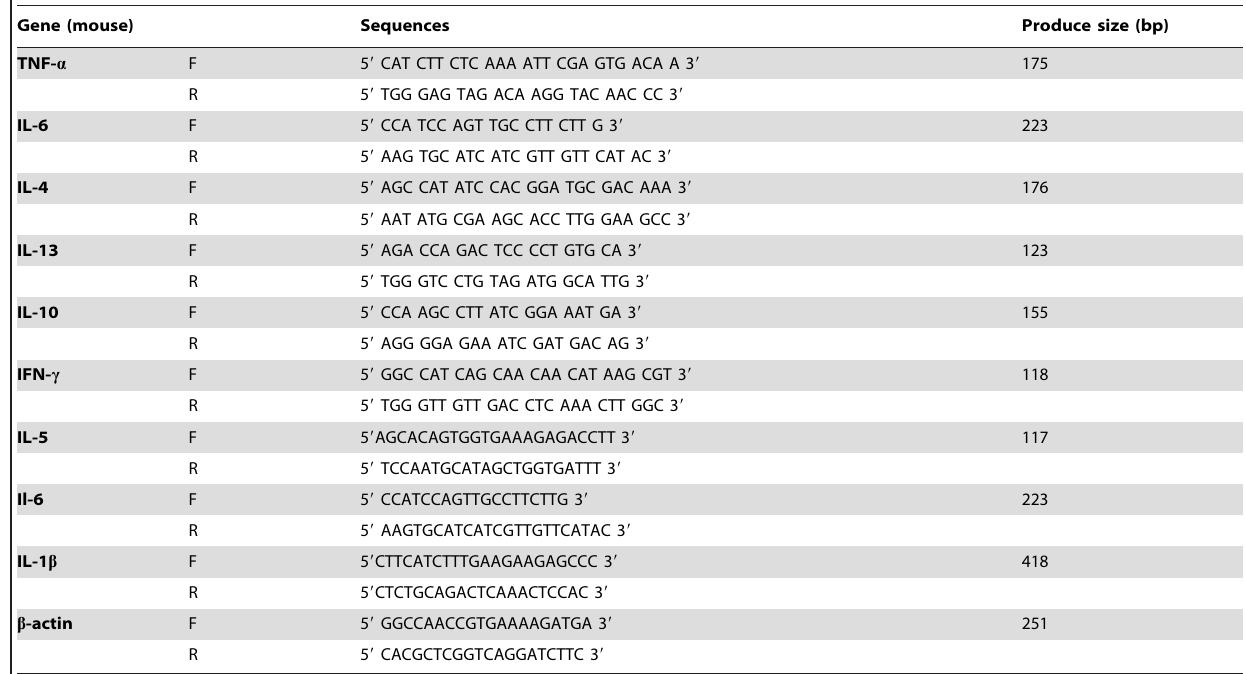
Gene (mouse) Sequences Produce size (bp)